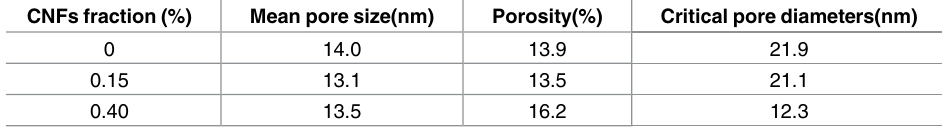
Table 4. The effect of CNFs addition on the pore